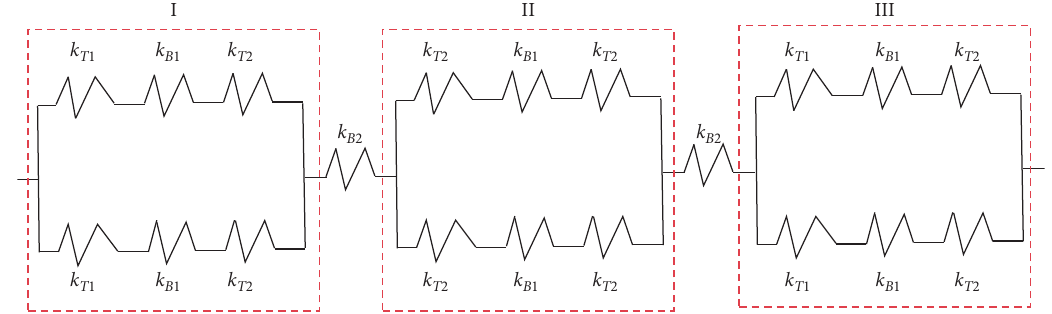
Figure 3: Schematic diagram of stiffness of the TLET-type flexure hinge.